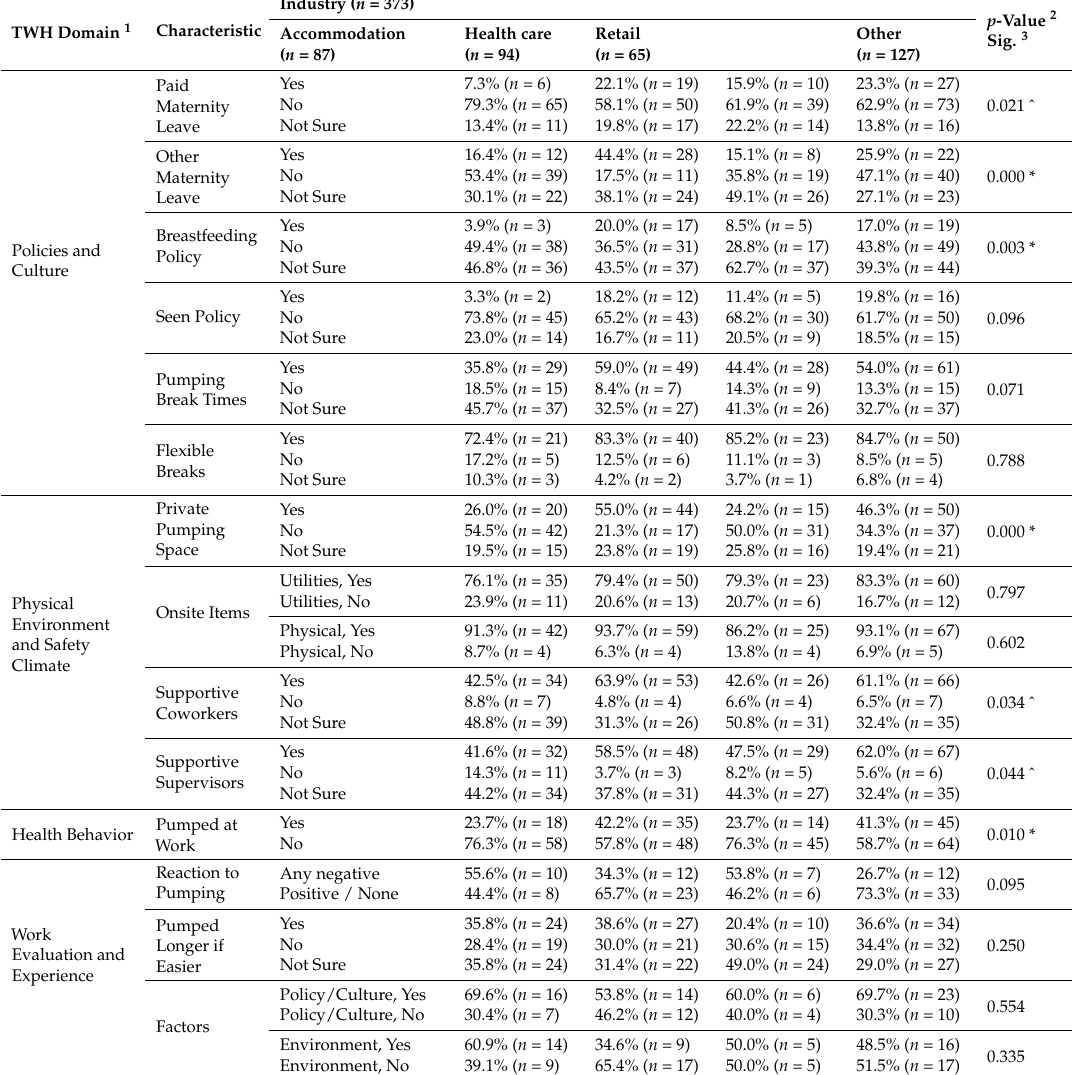
Table 6. Maternal Workplace Characteristics by